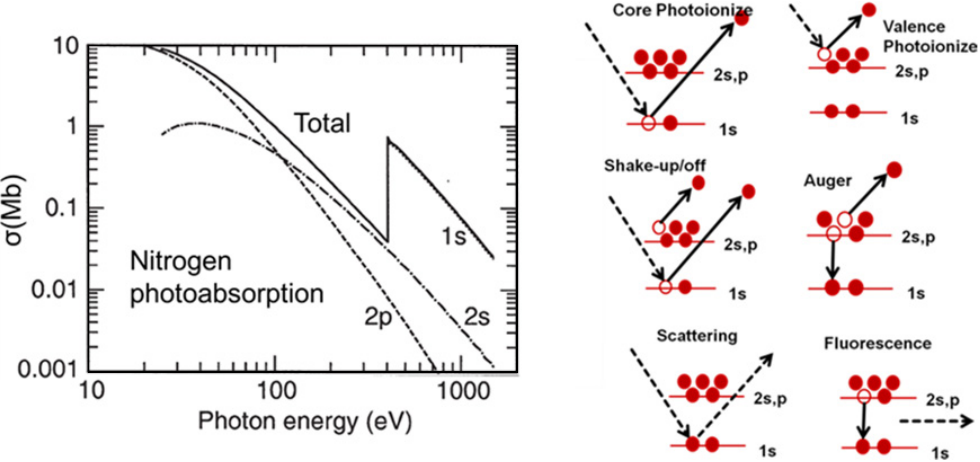
Figure 1. Left: Nitrogen absorption cross sections (After Yeh and Lindau [12]). Right: Schematic representation of the various x-ray atom interactions in nitrogen described in the